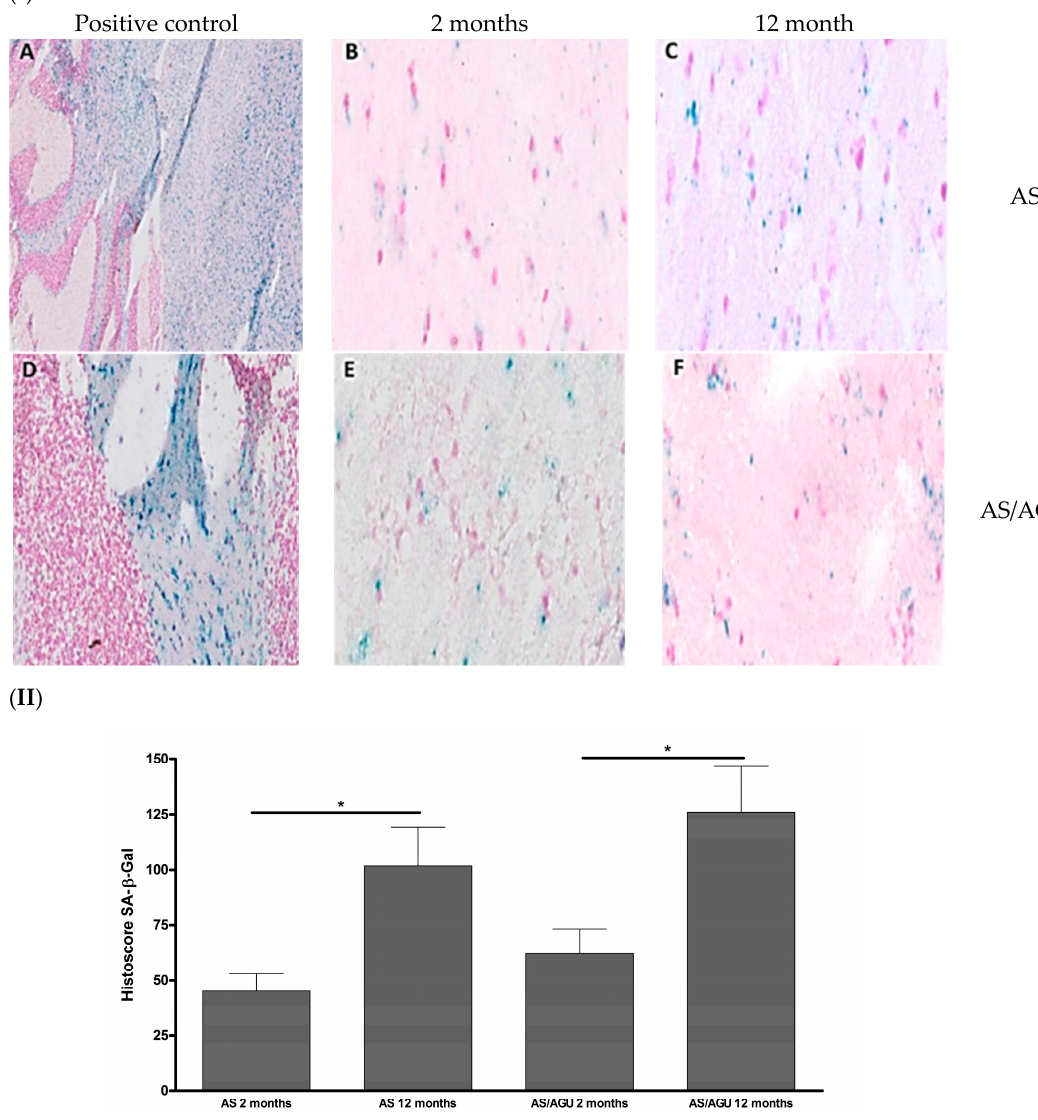
Figure 1. Senescence-associated β -galactosidase (SA- β -gal) in the sagittal sections of AS and AS/AGU rat stains in relation to age. ( I ) Immunohistochemical (SA- β -gal) activity. A : Twelve month AS pH4